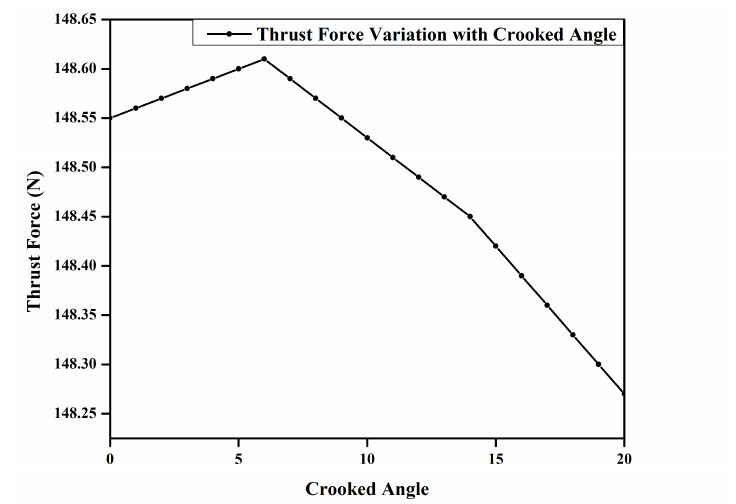
Figure 7. Variation of thrust force with crooked